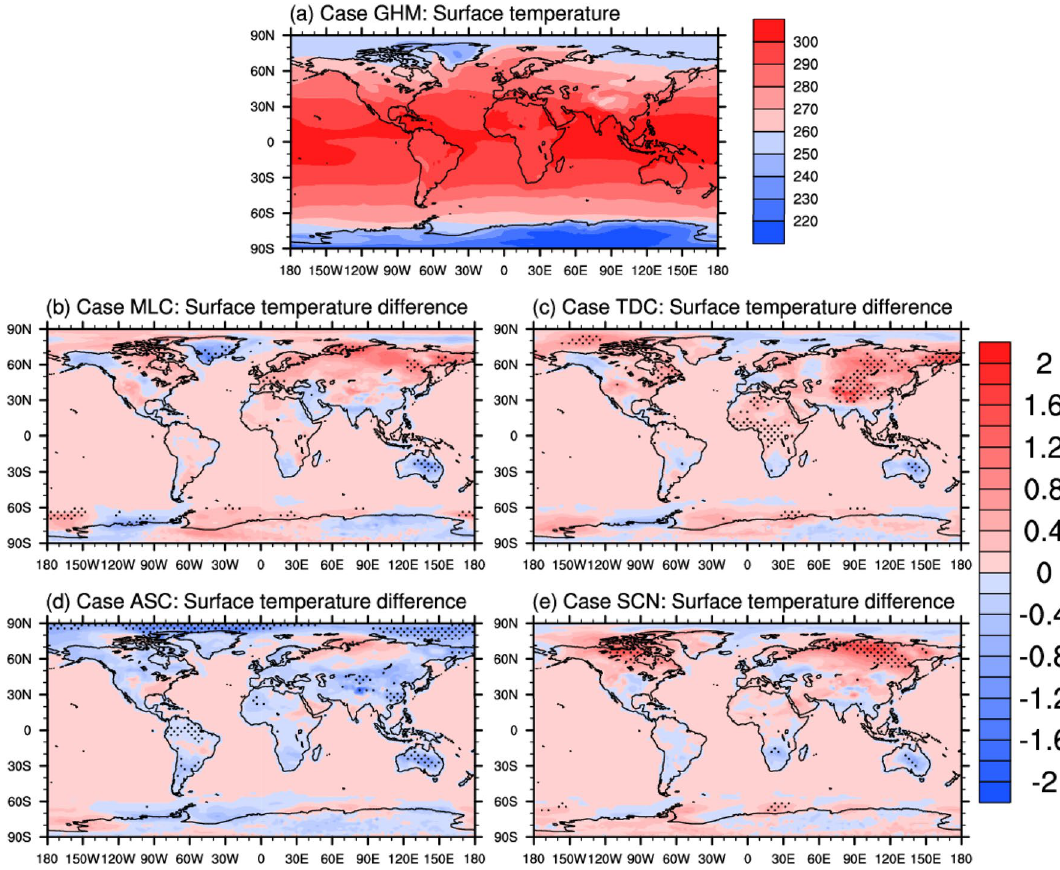
Figure 3. Simulated annual averaged surface temperature for the GHM case ( a ) and the corresponding differences between MLC, TDC, ASC, SCN and GHM cases ( b – e ). Unit: K. Stippled areas indicate significant differences at the 95% confidence